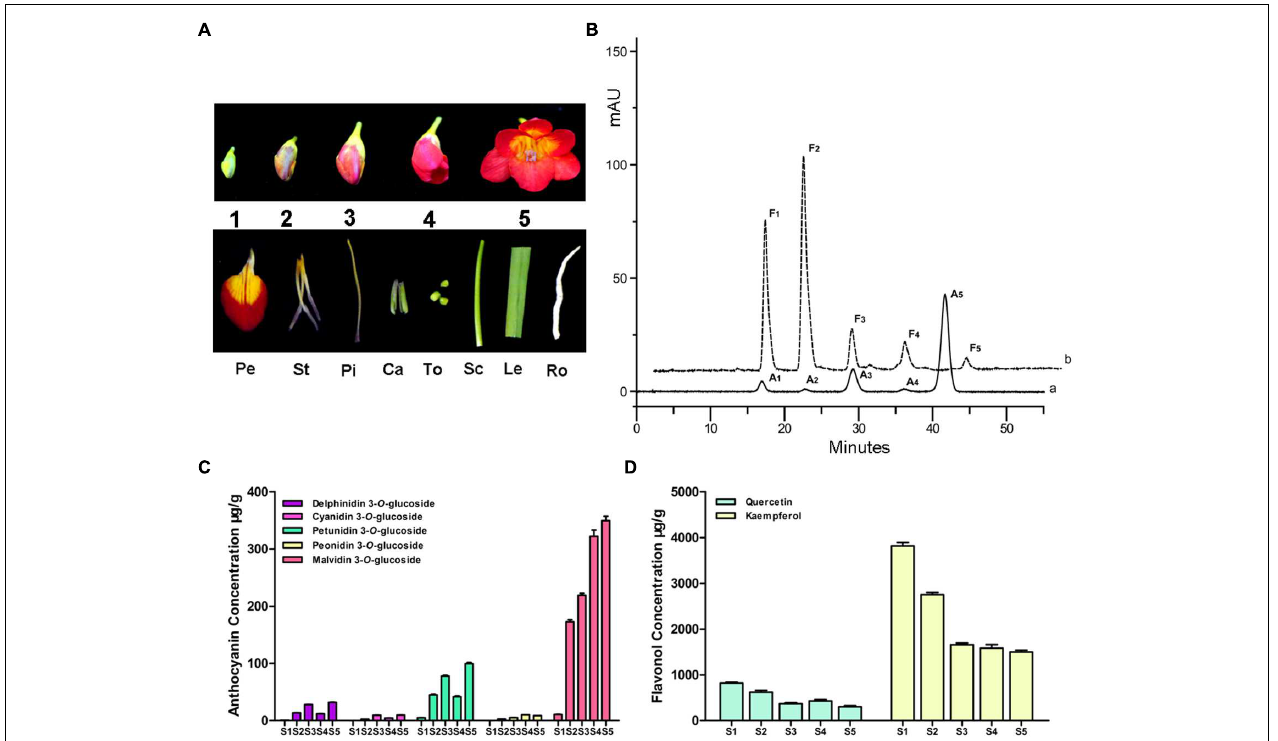
FIGURE 2 | Anthocyanin and flavonol component analysis in the flower of F. hybrida . (A) The phenotypes of different samples. S1–S5, represent the flowers of different developmental stages; Pe, petals; St, stamens; Pi, pistils; Ca, calyxes; To, toruses; Sc, scapes; Le, leaves; Ro, roots. (B) High performance liquid chromatography (HPLC) profiles of anthocyanins and flavonols in flowers. (a) monitored at 520 nm for anthocyan in (b) monitored at 360 nm for flavonol. (C) Quantitative analysis of individual anthocyanin during flower development. (D) Quantitative analysis of individual flavonol during flower development. Data represent means ± SD of three biological